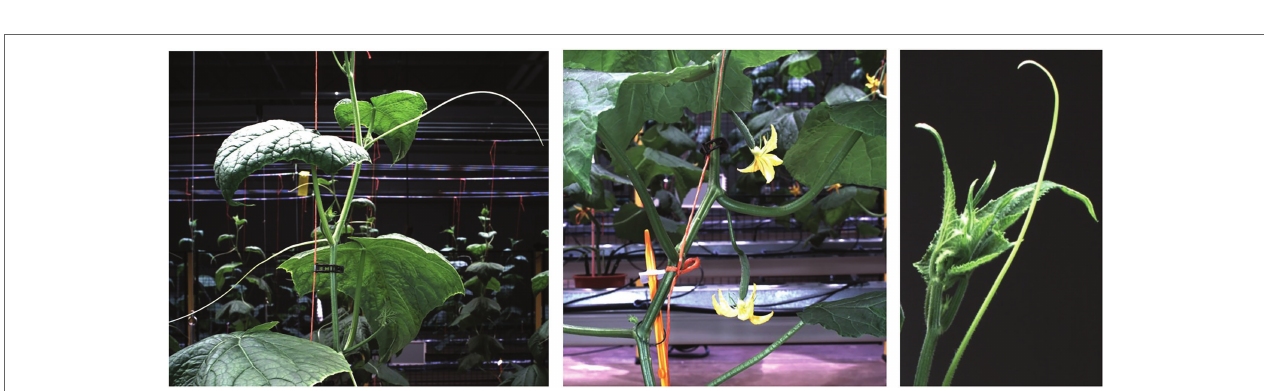
FIGURE 1 | The mobile platform (left) including the Phenospex F500 Dual-scan system. The right image shows a schematic top-down overview of the plants in the climate chamber. The mobile platform automatically moved to the scan positions. At each position, the corresponding plant was scanned in a vertical direction by moving the scanners upwards (Boogaard et al., 2021).